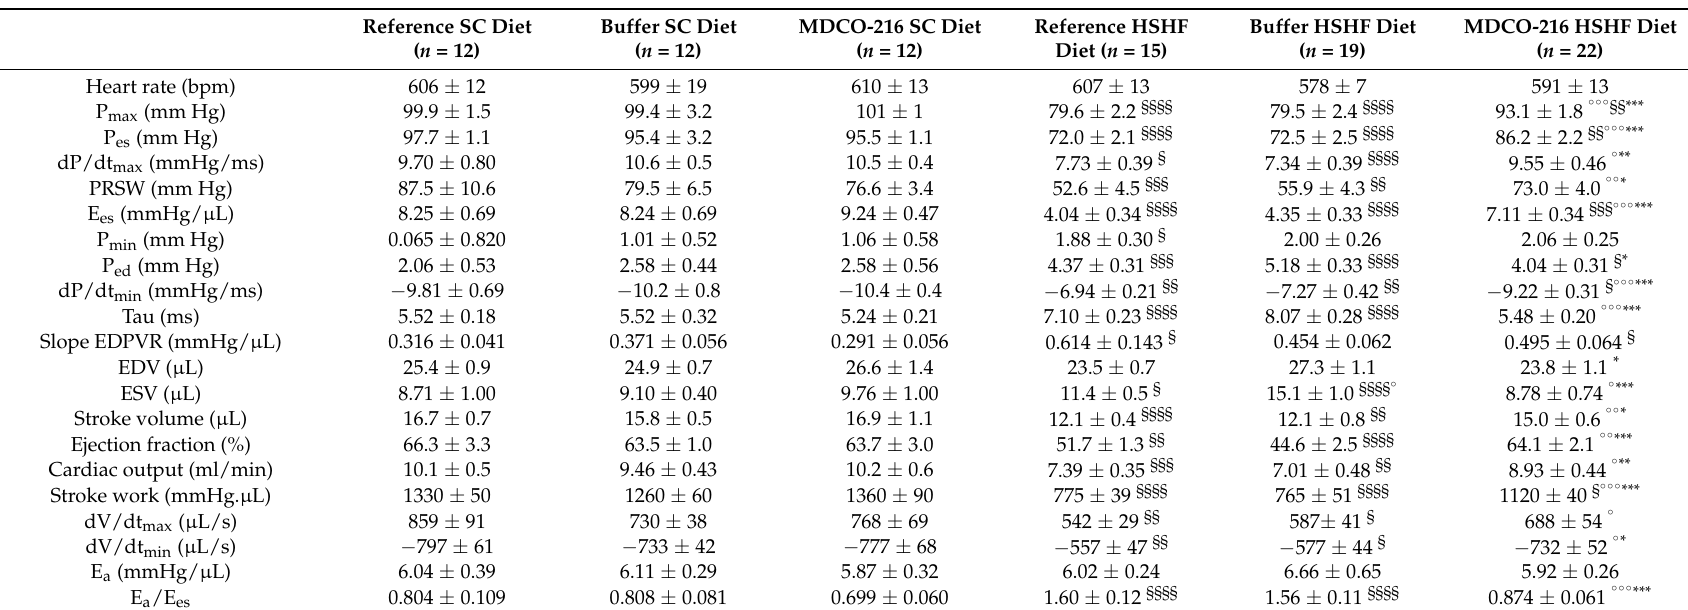
Table 6. Overview of hemodynamic data in reference, buffer, and MDCO-216 C57BL/6N mice fed the SC diet or the HSHF